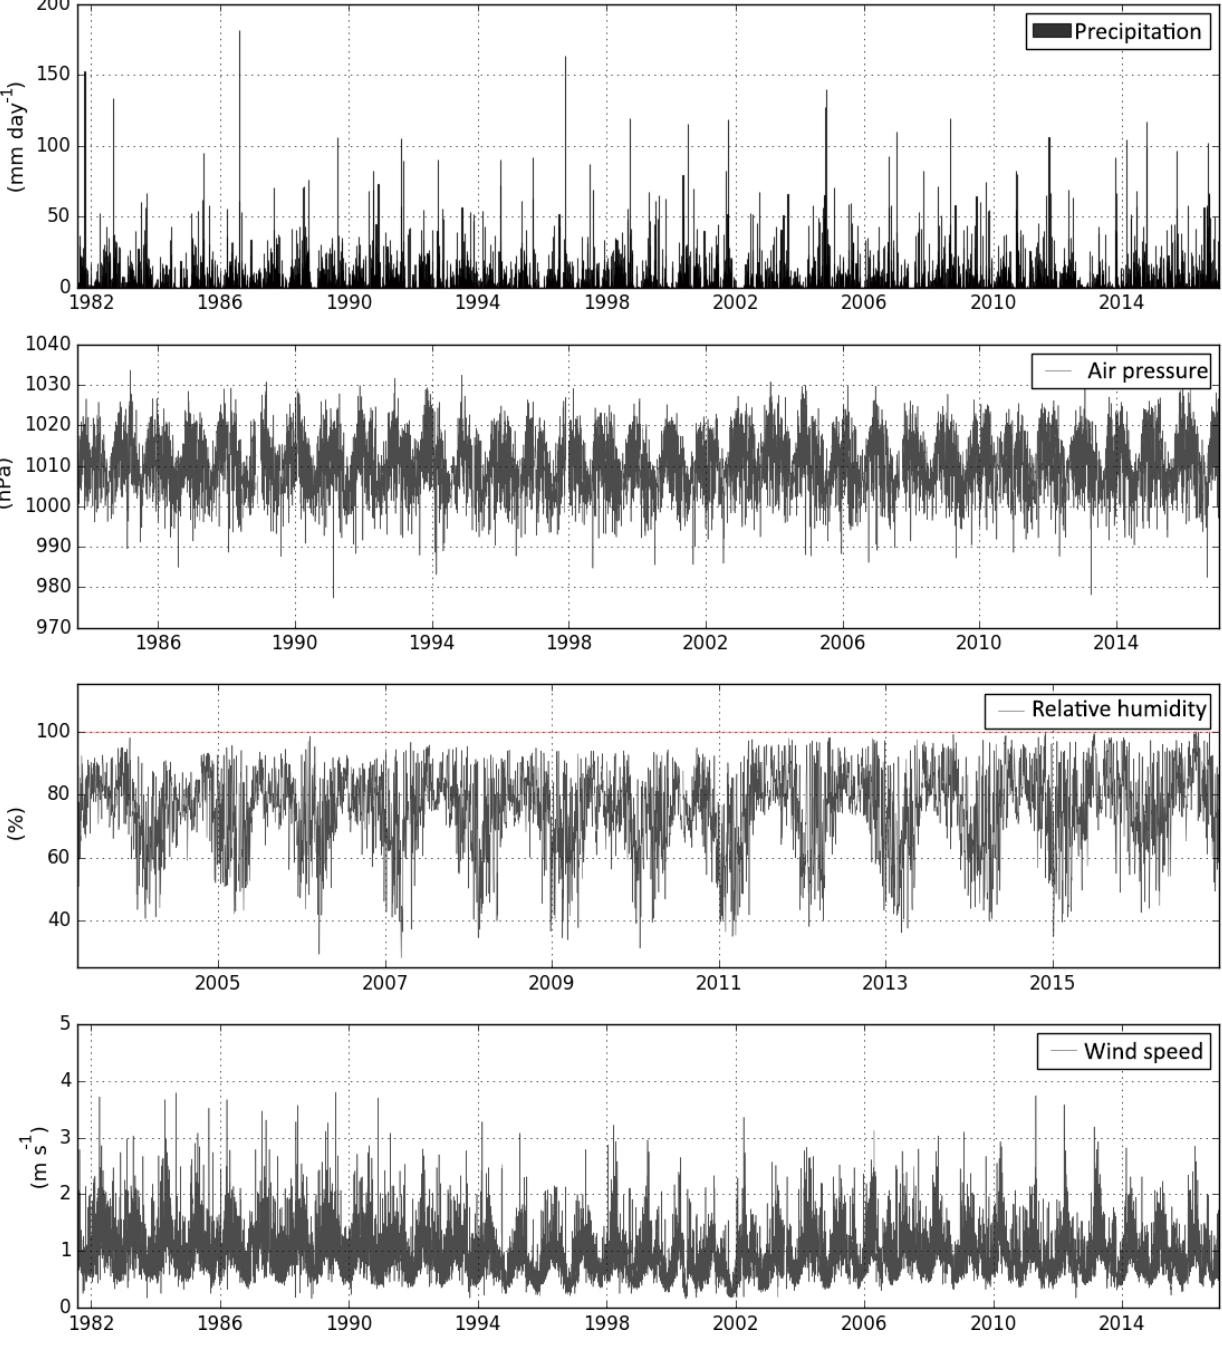
thereafter, so that the minimum air temperature shows a